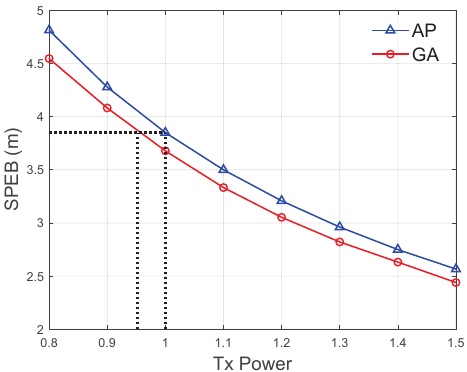
Figure 6. SPEB with different Tx power level of